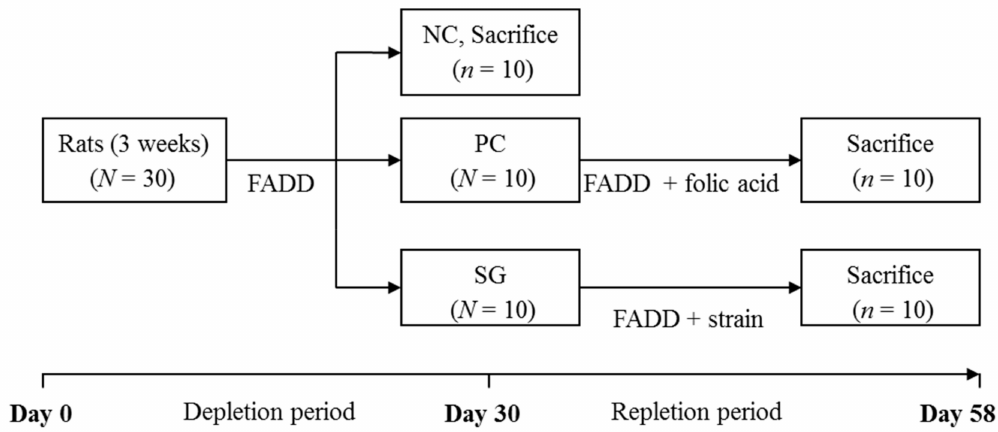
Figure 1. Folate depletion–repletion feeding protocol. NC: Negative control group, rats fed with a folic acid-deficient diet (FADD); PC: Positive control group, rats fed FADD containing 2 mg folic acid / kg of diet; SG: Strain group, rats fed with FADD supplemented with lyophilised L. plantarum P2R3FA strain containing 0.25 mg of folate / kg of diet. N = total number of animals per group. n = number of